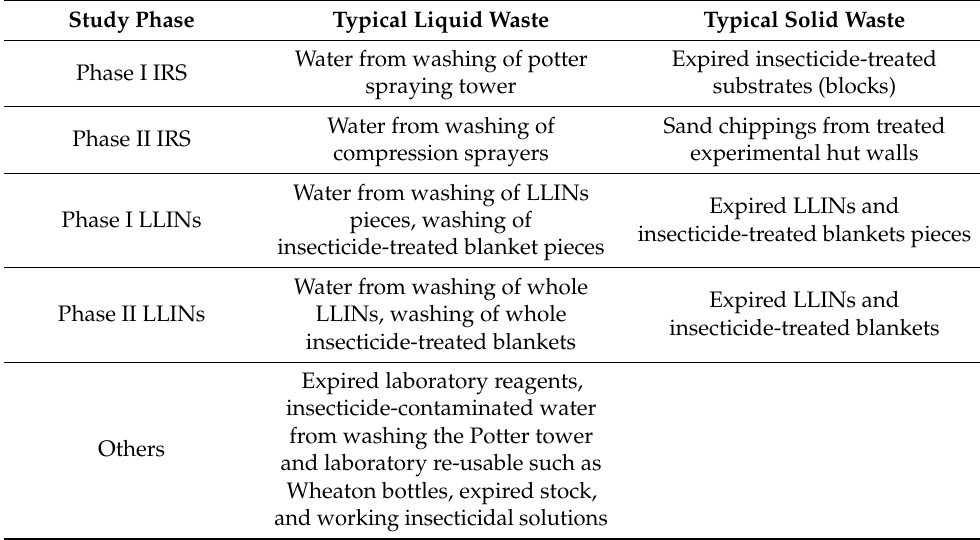
Table 2. Typical insecticidal wastes from various